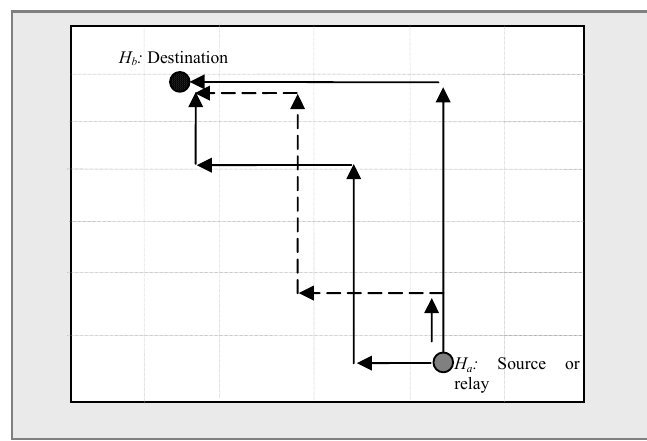
Figure 7. Multiple Shortest Routes